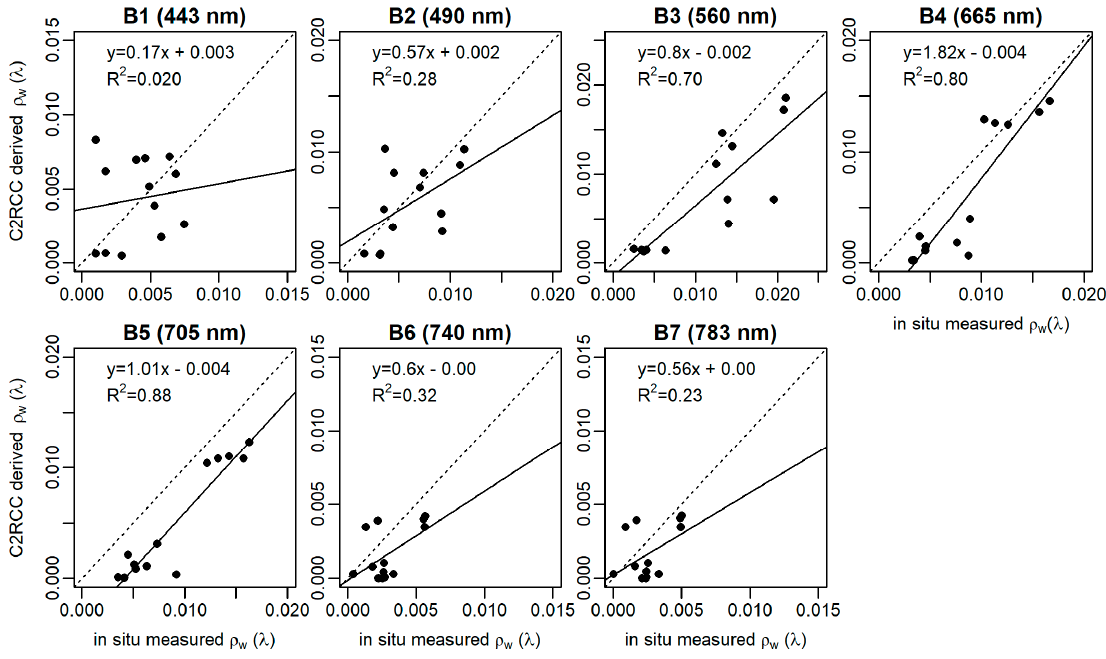
Figure 4. Comparison of all 13 points of Case 2 Regional CoastColour (C2RCC) derived ρ w ( λ ) versus in situ measured ρ w ( λ ) at S2 MSI wavelengths. Dotted line represents 1:1 line and constant line is the trendline.